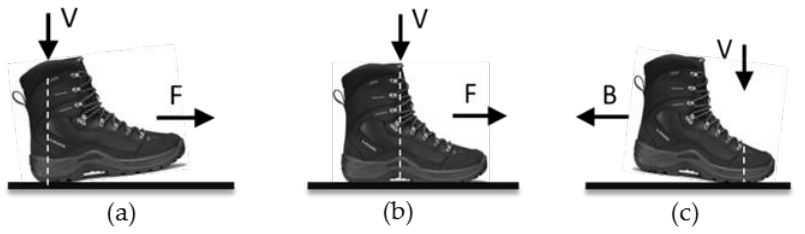
Figure 3. Three test modes: ( a ) Forward heel slip, ( b ) Forward flat slip and ( c ) Backward toe slip, as described in standard mechanical testing (ASTM) F2913-19 [39]. The vertical arrow (V) represents the line of action of the vertical force with respect to the sole-surface contact area. The horizontal arrow represents the forward (F) or backward (B) sliding direction of the footwear relative to the surface.